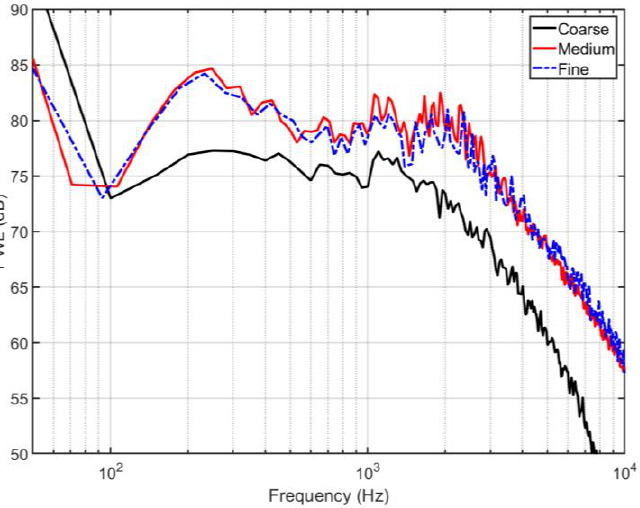
Figure 6. The variation of the sound power level (PWL) of the baseline flap side-edge against the grid resolution level.